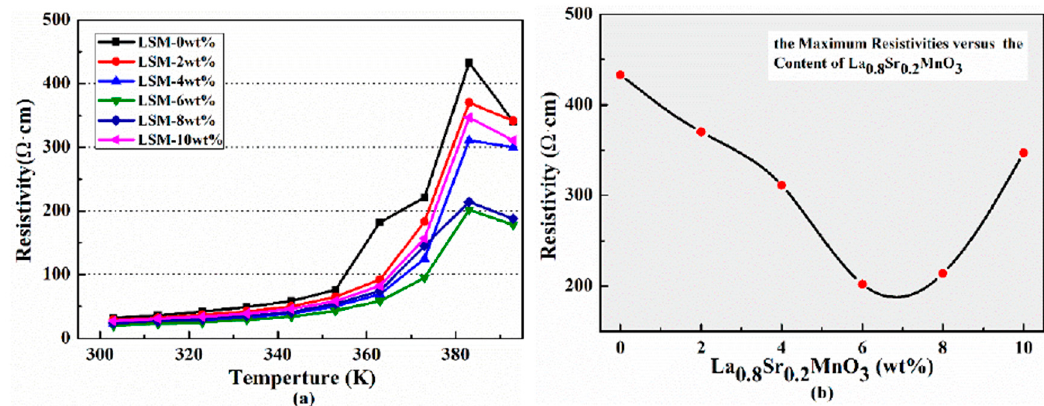
Figure 8. Resistivity-temperature behaviors of La 0.8 S r0.2 MnO 3 / semi-conductive composites. ( a ) Resistivity of La 0.8 Sr 0.2 MnO 3 / semi-conductive composites versus temperature; ( b ) maximum resistivity versus La 0.6 Sr 0.4 MnO 3 content.